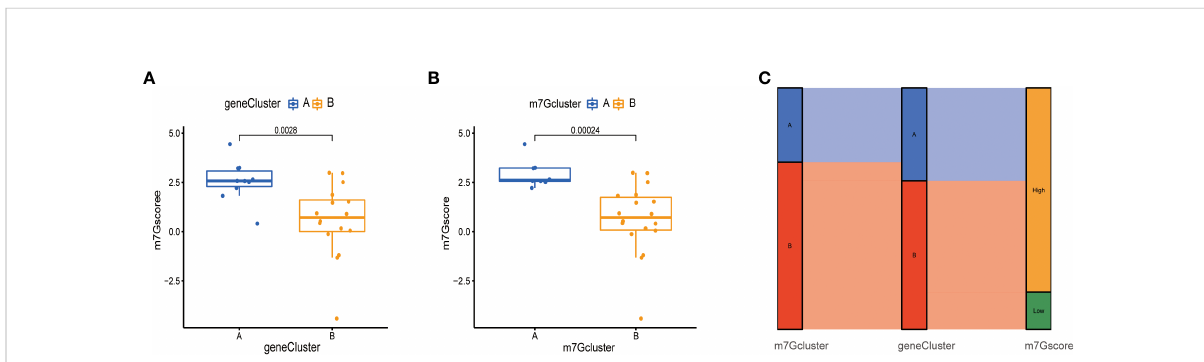
FIGURE 7 Construction of m 7 G score. (A) Score of m 7 G in gene Cluster. The abscissa represents different gene cluster, and the ordinate represents the score of this gene. (B) Score of m 7 G in m 7 G cluster. (C) Alluvial diagram of show gene cluster in relation to m 7 G cluster and m 7 G